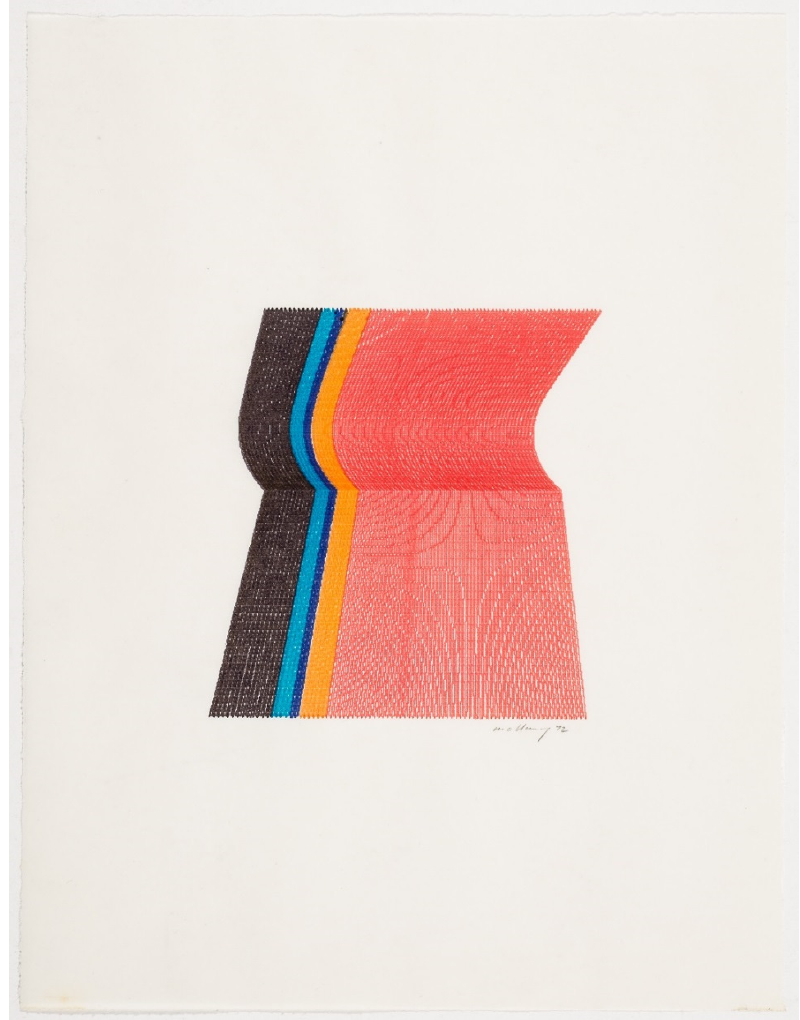
Figure 9. Robert Mallary, Colour Plotter Graphic, 1972. 8.6 × 11 ins. Image courtesy Mayor Gallery London. Made on the Amherst College IBM system using artist-designed program GRAF/D written in FORTRAN IV. The program stops while the different coloured pens are changed by hand.